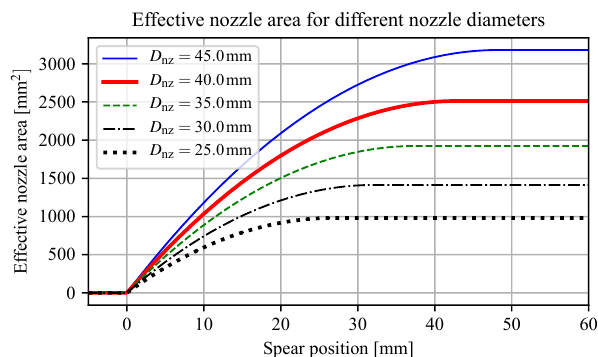
Figure 9. Effective nozzle area as a function of the spear position in the circular nozzle cross section. The spear valve is fully closed at s = 0mm and fully opened at s = s max , the latter of which is variable according to the nozzle head diameter.